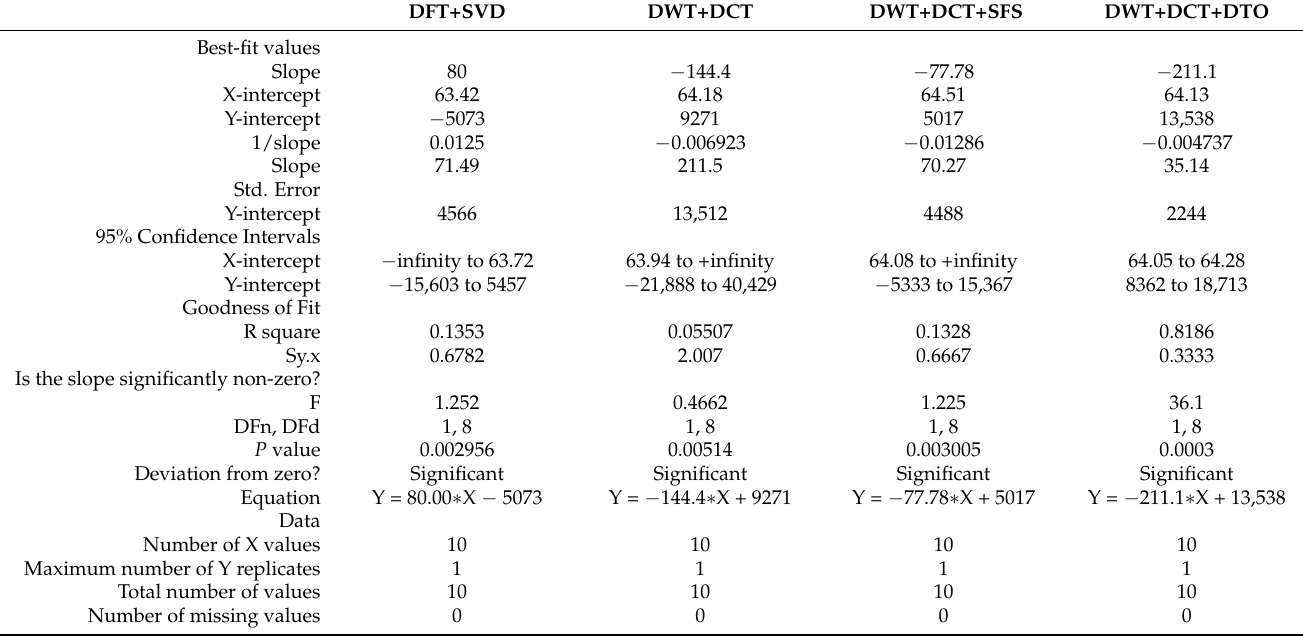
Table 5. The regression test between the proposed watermarking method and each one of the other competing watermarking